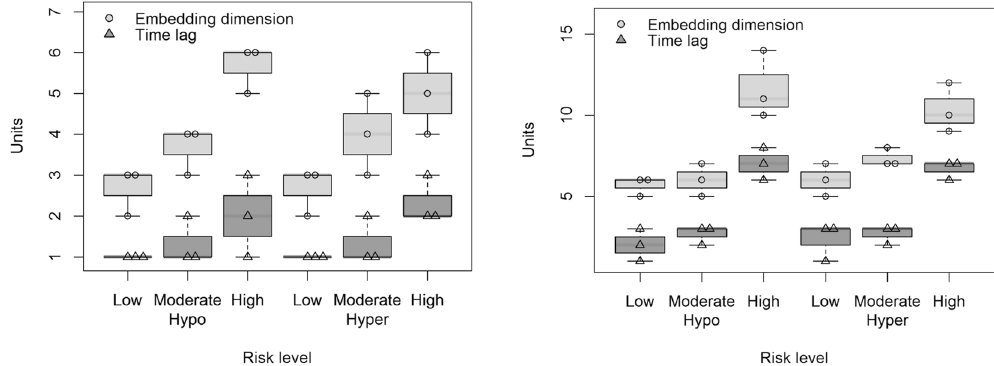
Figure 4. Embedding dimension m and time delay τ for time series of landmarks at different risk levels of hypo- and hyper-glycemia for a PH of 30 minutes (left) and 60 minutes (right).